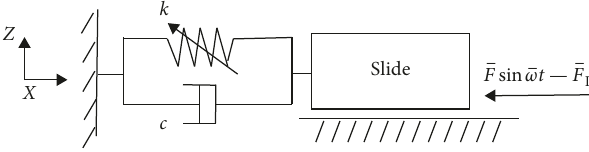
Figure 4: Single-degree-of-freedom mechanical system.